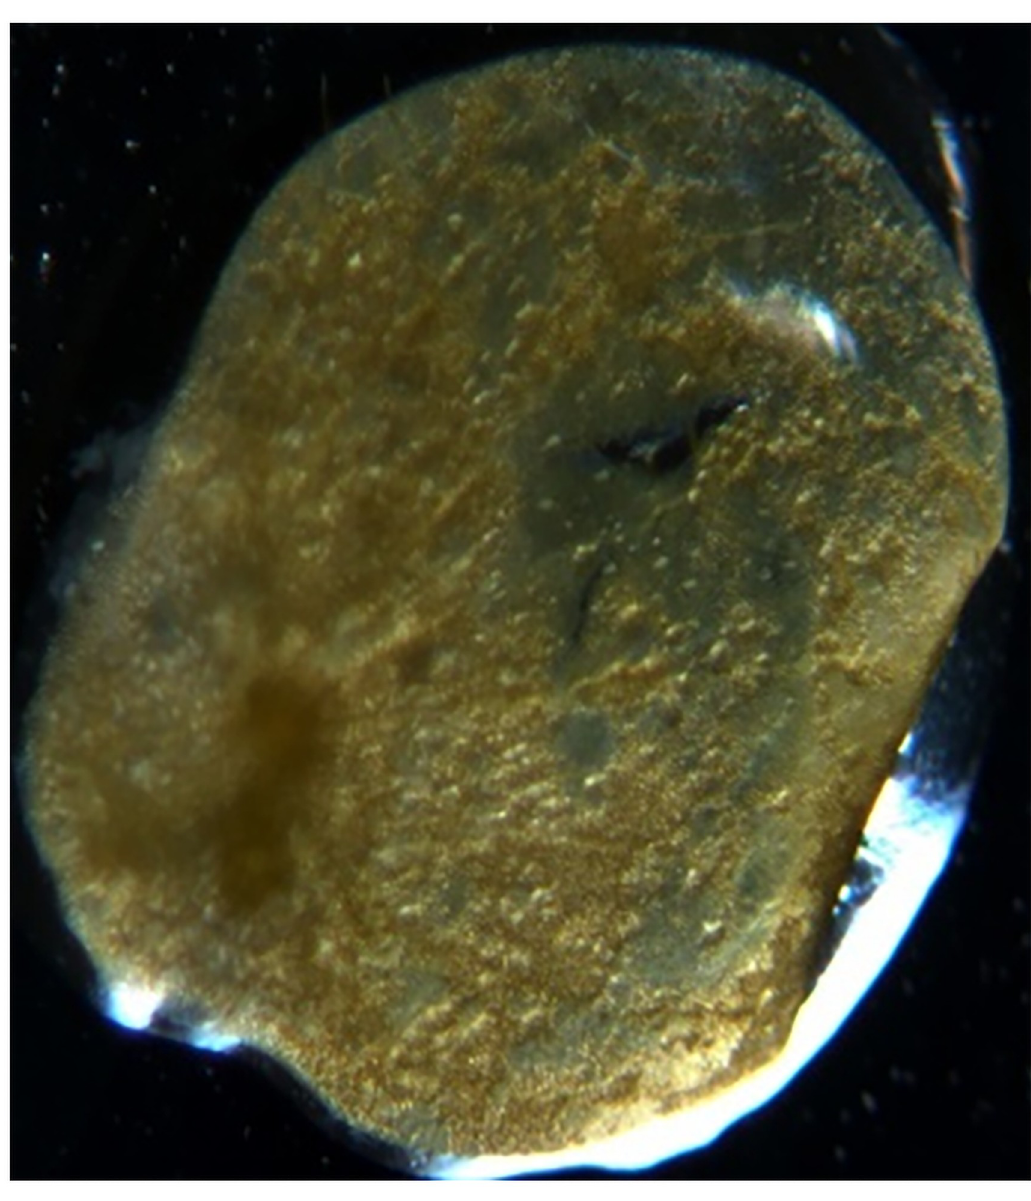
Fig 5. Photo of Lemna minor duckweed aged for 10 days in a solution of CuSO influenced to MF H = 4